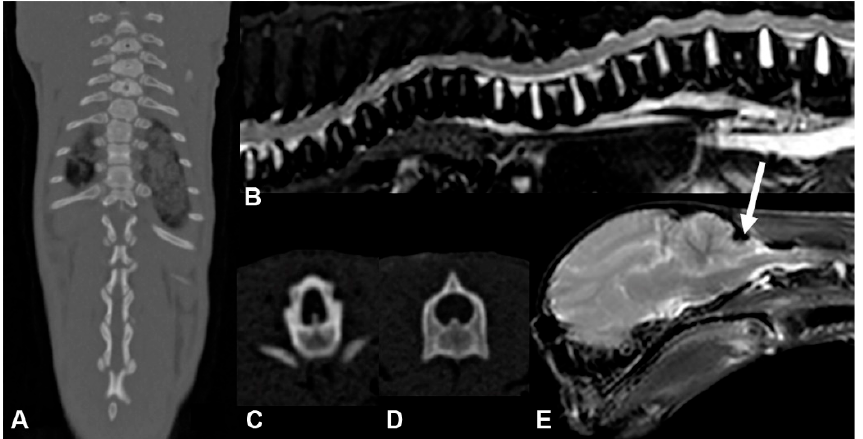
Figure 2. CT / MRI images of the affected male kitten. ( A ) CT image of the thoracic region in dorsal view. ( B ) T2-weighted sagittal MRI image of the vertebral column. ( C ) Transverse CT image of the vertebral body at the level of Th13. ( D ) Transverse CT image of the vertebral body at the level of L5. ( E ) T2-weighted sagittal MRI image of the brain with cerebellar herniation (white arrow).